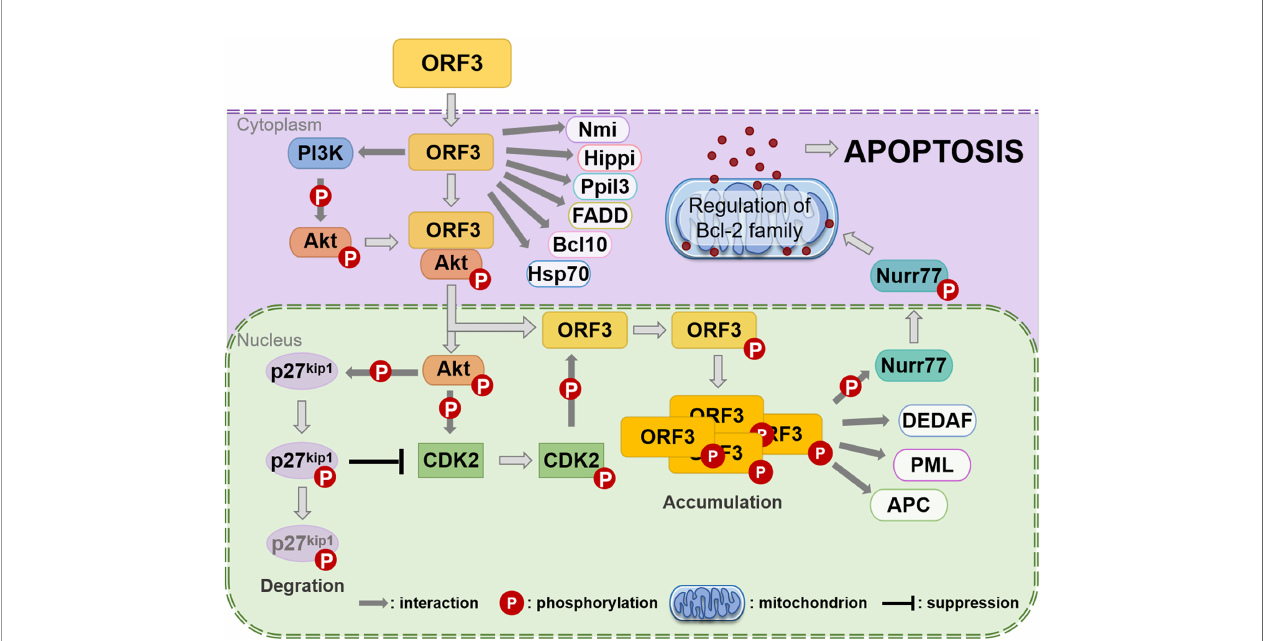
FIGURE 3 | Assumption of the CAV ORF3 protein-induced apoptosis of tumor cells (Los et al., 2009). Through association with PI3-K, the ORF3 protein can lead to constitutive activation of PI3-K and the subsequent phosphorylation of Akt. The nuclear translocation of Akt activates CDK2 by direct and indirect phosphorylation, which subsequently phosphorylates the ORF3 protein at Thr108. Then, the ORF3 protein is forced to accumulate in the nucleus. In the cytoplasm, the ORF3 protein can interact with various proteins, including Nmi, Hippi, Ppil3, FADD, Bcl10, and Hsp70. In the nucleus, the ORF3 protein associates with other types of interaction partners, such as DEDAF, PML and APC. In addition, the ORF3 protein can trigger Nurr77 phosphorylation and then make its nuclear export. Nurr77 in the cytoplasm is known to regulate the Bcl-2 family such that apoptosis is induced via the mitochondrial